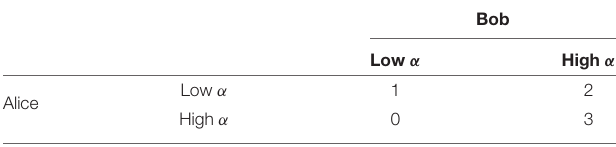
TABLE 3 | Structure of the game faced by Alice.